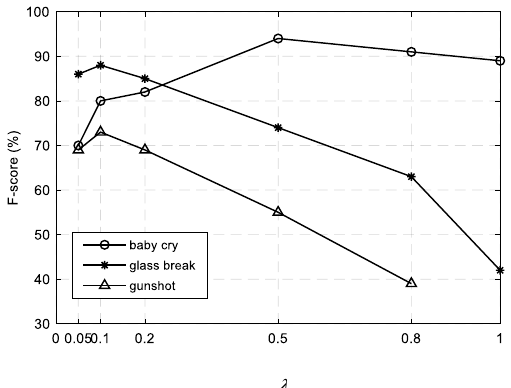
Figure 5. F-score results for three event classes under different values of the sparsity parameter λ . The results are obtained on the development dataset by the supervised NMF method without weighting [14].